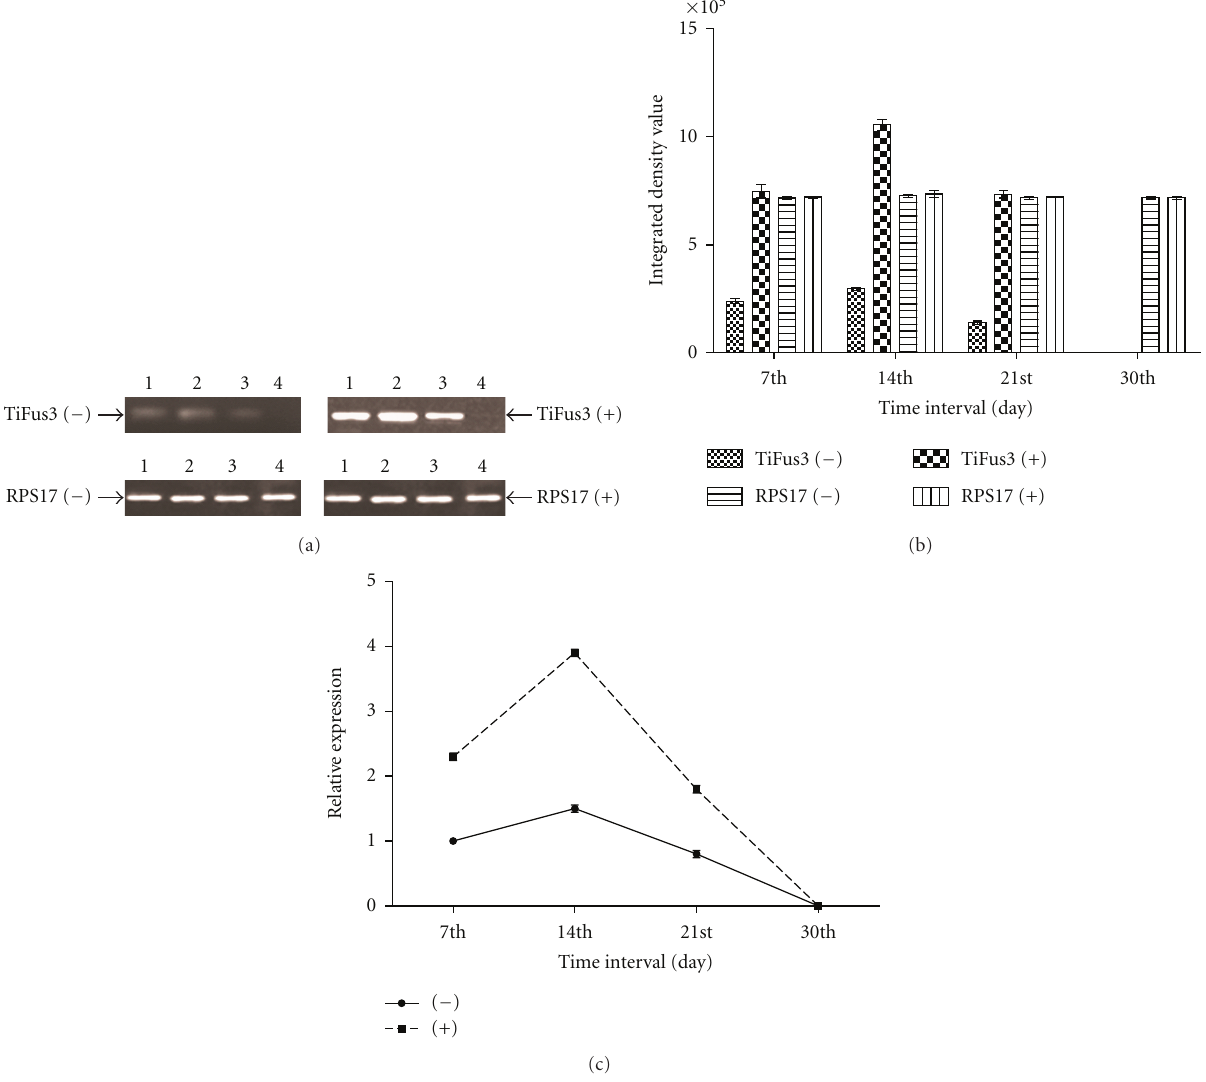
Figure 3: (a, b and c) Expression analysis of TiFus3 gene in T. indica isolate in absence of host factor ( − ) and in presence of host factor (+) at di ff erent days of growth and development in liquid culture. (a) Semiquantitative RT-PCR analysis—RT-PCR of expressed messenger RNA at 7th, 14th, 21st, and 30th day (lane 1 to 4, resp.) with RPS17 rRNA transcript used as internal control. (b) Densitometry analysis- Integrated density value based on densitometry analysis was done with the help of gene profiler software, Alpha Innotech Corporation USA. (c) Quantitative real-time PCR analysis—relative expression using real-time